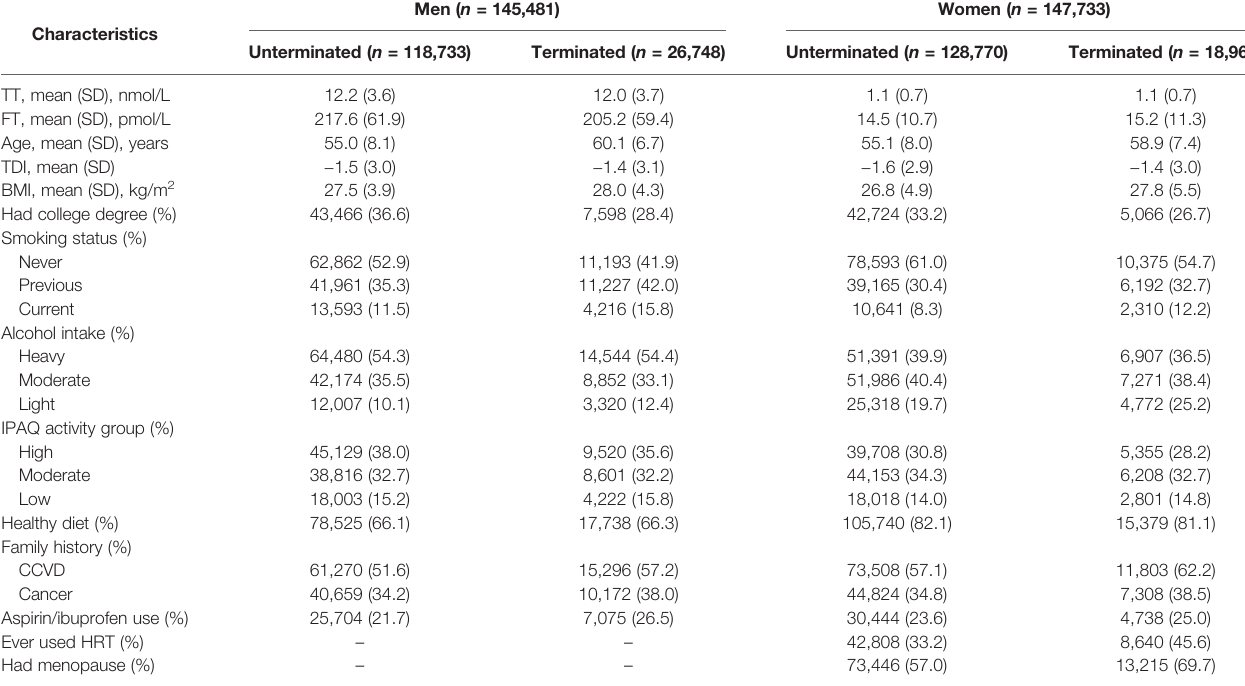
TABLE 1 | Baseline characteristics of participants with or without terminated health span.